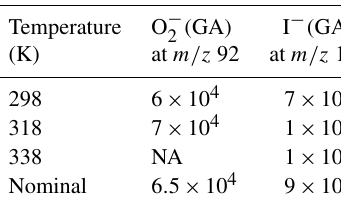
Table 6. Glycolaldehyde sensitivities for the melt vapor pressure source experiment (cpsppb − 1